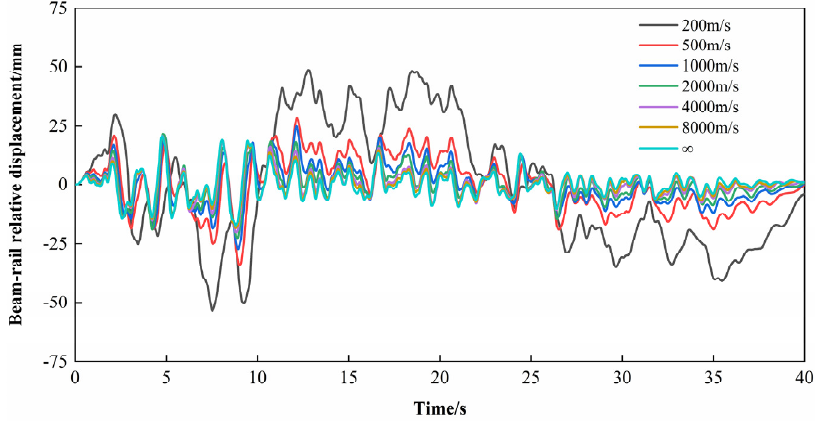
Figure 12. Time-history curve of beam–rail relative displacement at point A under different apparent wave velocities. Table 5. Numerical value of PPMCC.